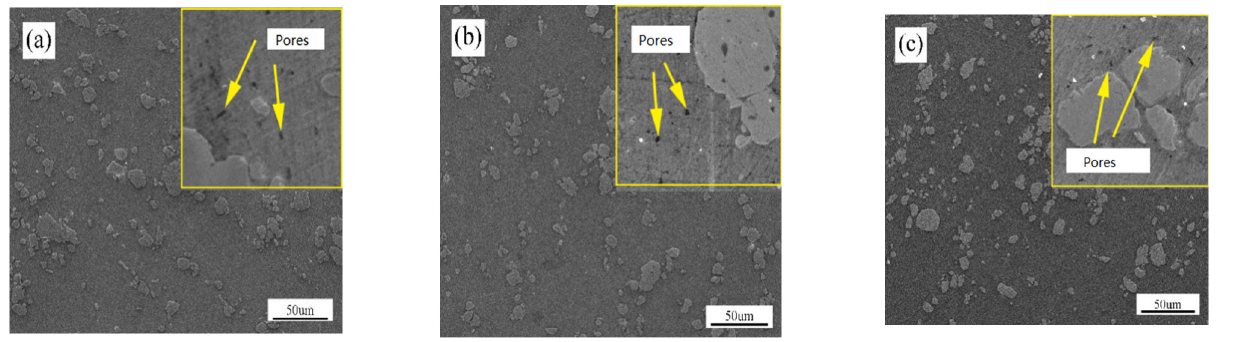
Figure 10. Microstructure and morphology of 10 vol.% (AlFeNiCrCoTi0.5)p/6061Al matrix composites with different extrusion passes: ( a ) one extrusion pass, ( b ) two extrusion passes, and ( c ) three extrusion passes.